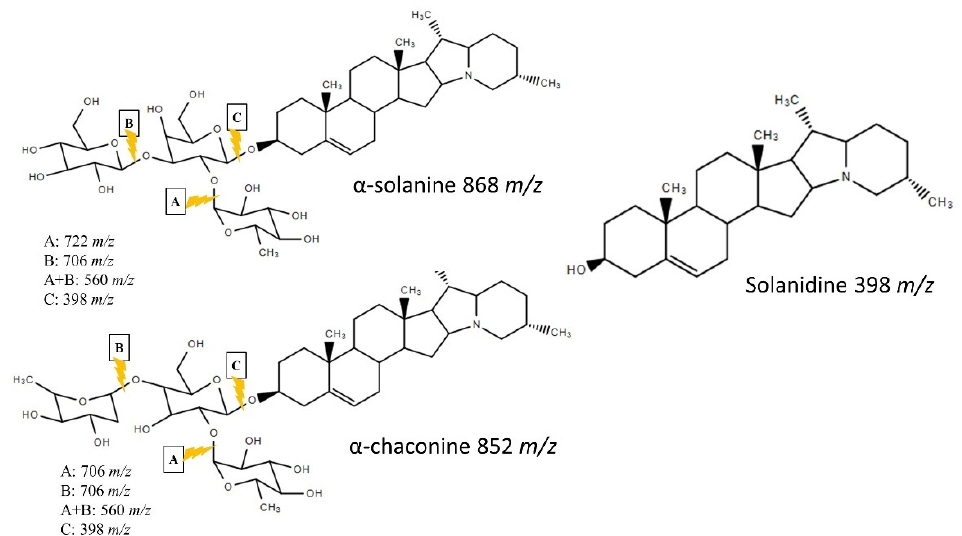
Figure 3. Structure of α -solanine, α -chaconine, and solanidine with indication of their fragmentation (drawn using ChemSpider). Lightning indicates in-source fragmentation producing addition ions. Table 1. Ions used in single ion monitoring for quantification of glycoalkaloids (GAs) by LC-ESI / MS.